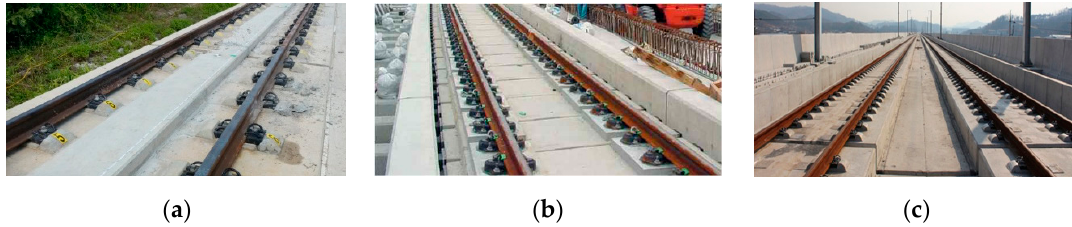
Figure 16. Types of derailment containment provision (DCP). ( a ) DCP Type 1, ( b ) DCP Type 2, ( c ) DCP Type 3.